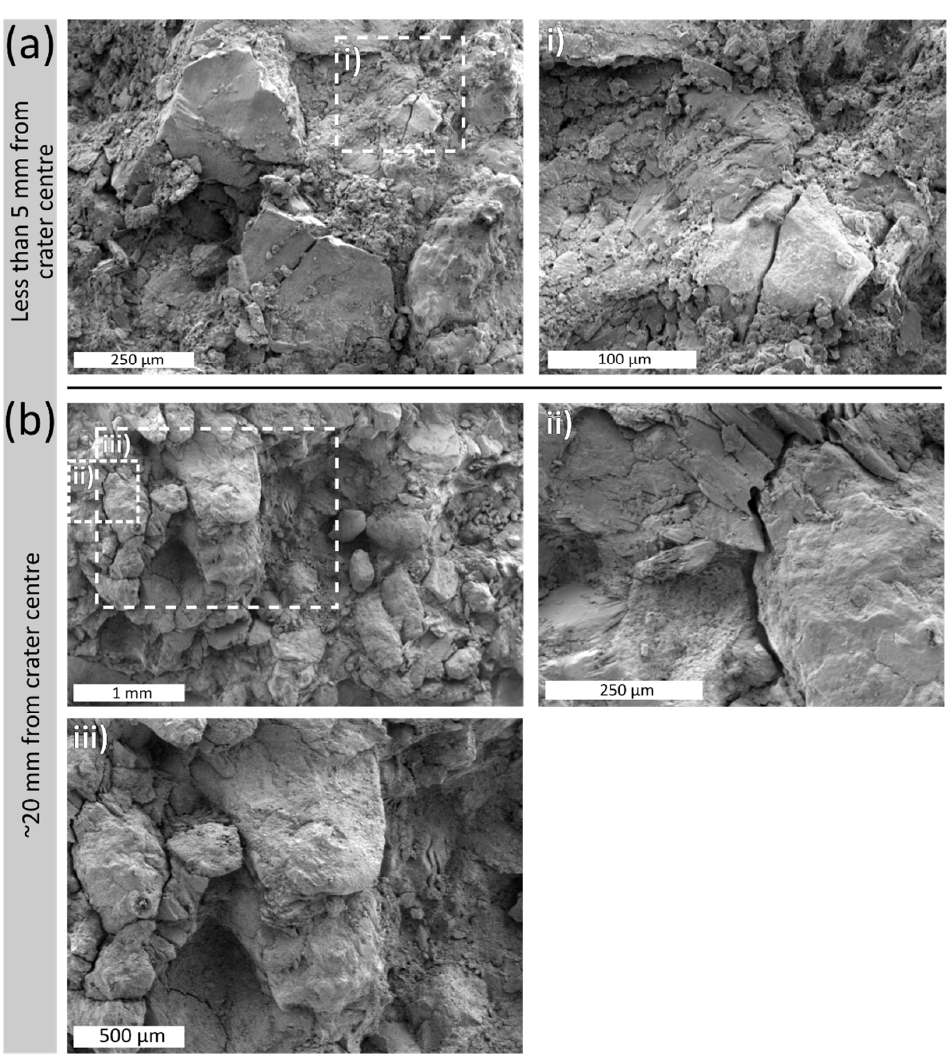
Figure 3. Backscatter electron (BSE) image of surface damage within the impact crater. ( a ) HS_IC is sampling the crater centre, showing heavily comminuted material, conchoidal fracture surfaces on quartz grains, and intragranular fracture paths ( i ). ( b ) Sample HS_CR from the spall zone of the impact crater shows grain plucking, less comminution, fracturing of clay minerals at a high angle to cleavage ( ii ), and a larger proportion of fractures having circumgranular paths around grains ( iii ).